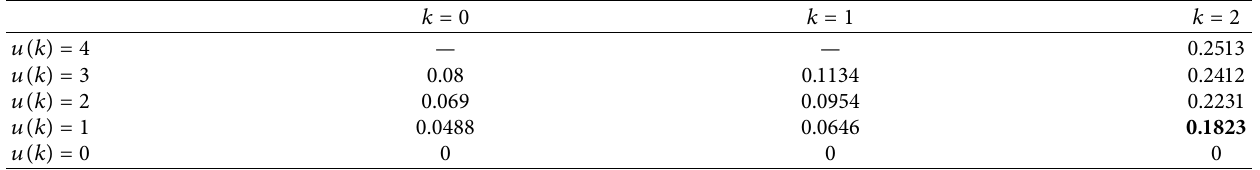
Table 3: Values of L ( u ( k ) ,k ) for various values of u ( k ) .